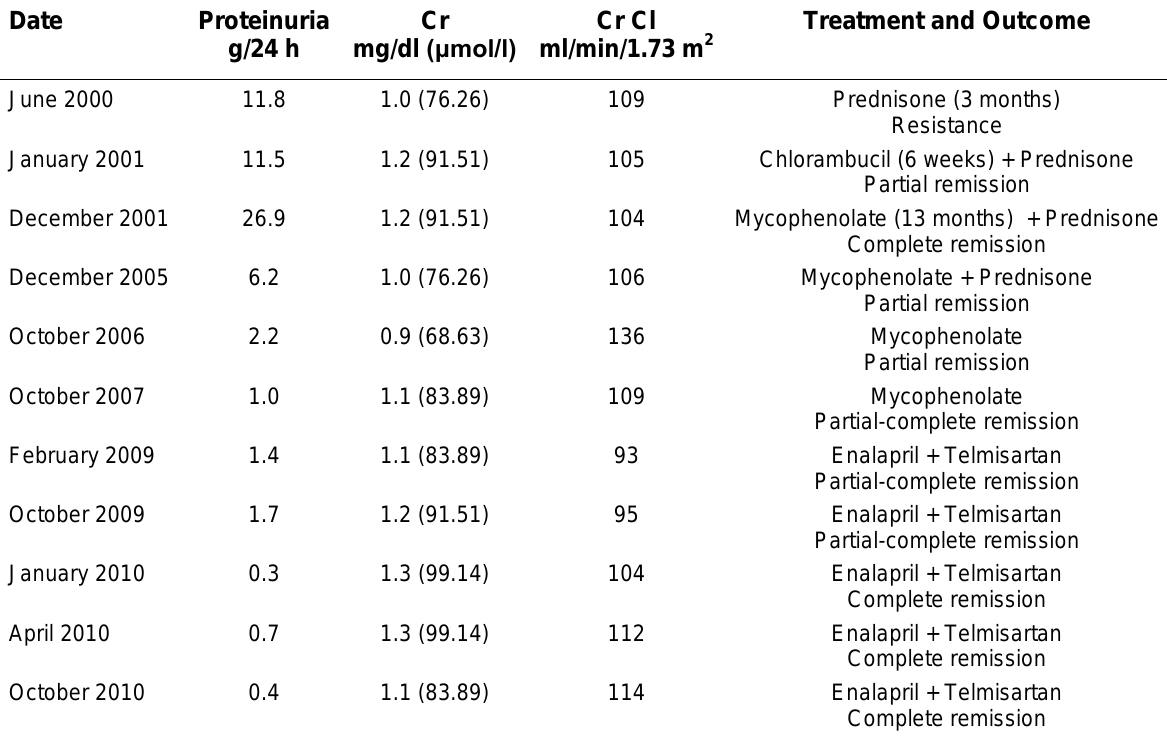
Evolution of an ADPKD Patient with Nephrotic Syndrome and